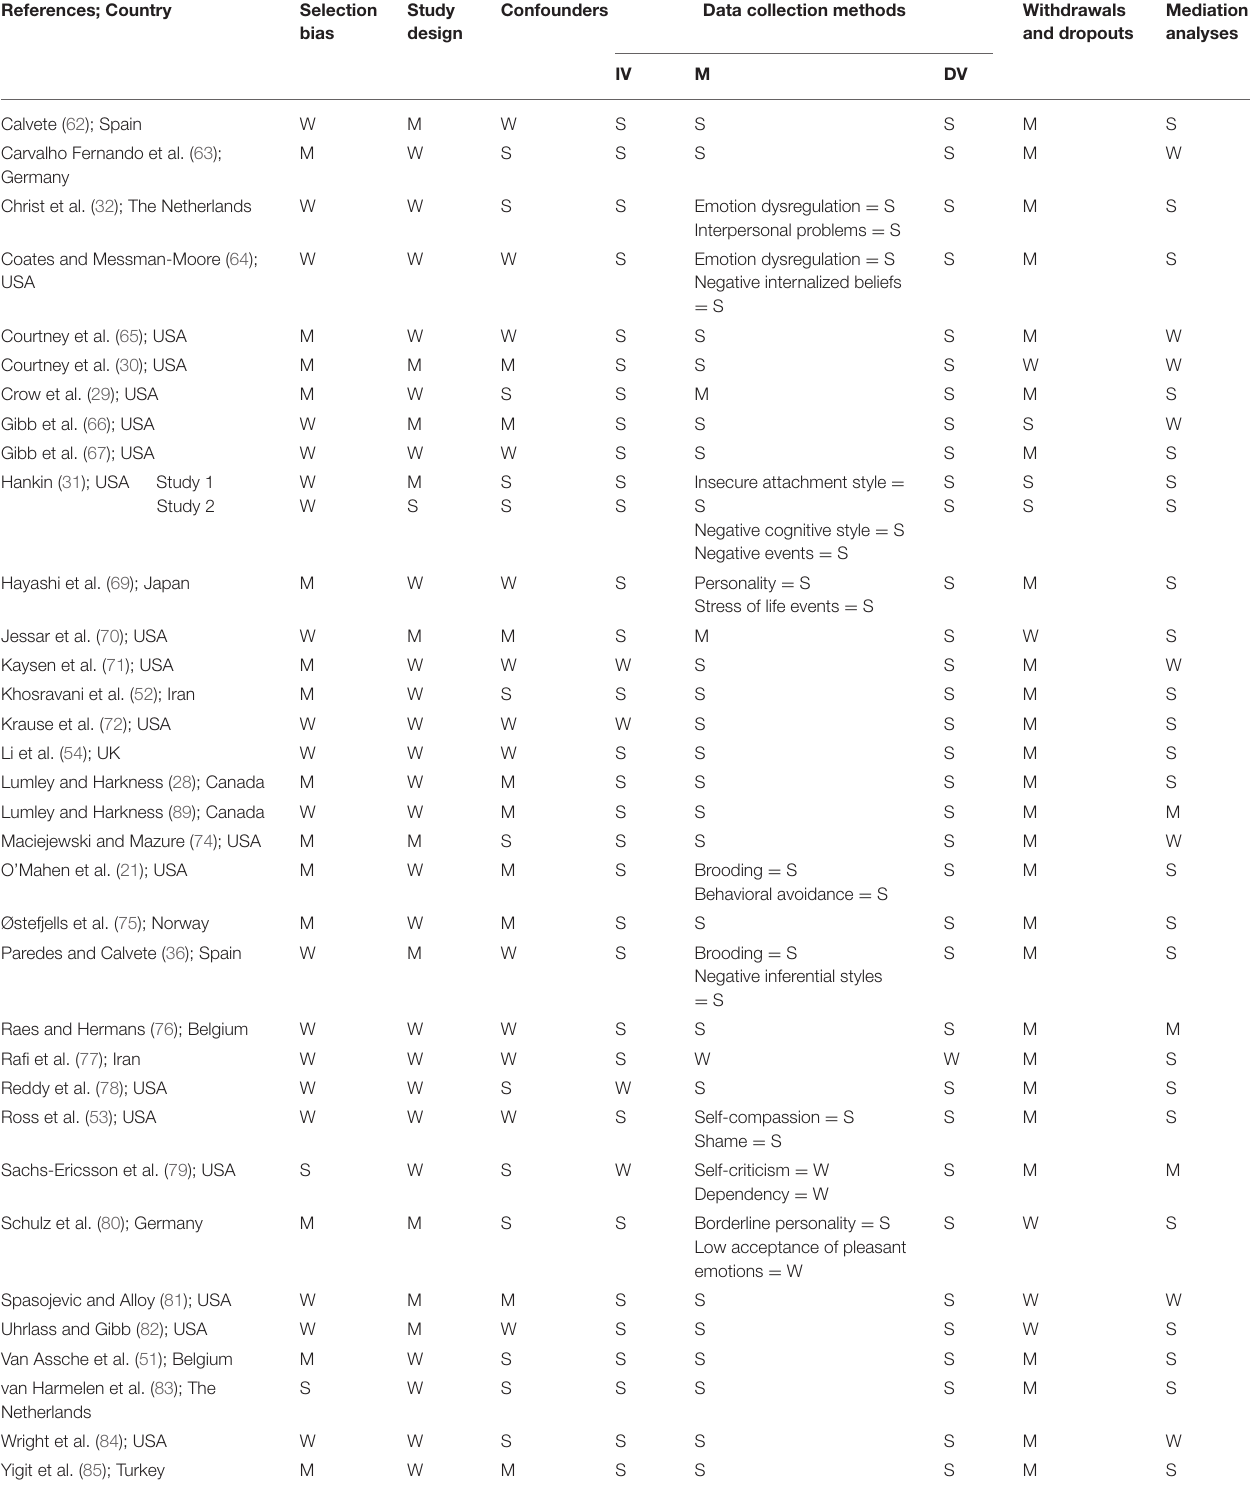
TABLE 2 | Quality assessment tool